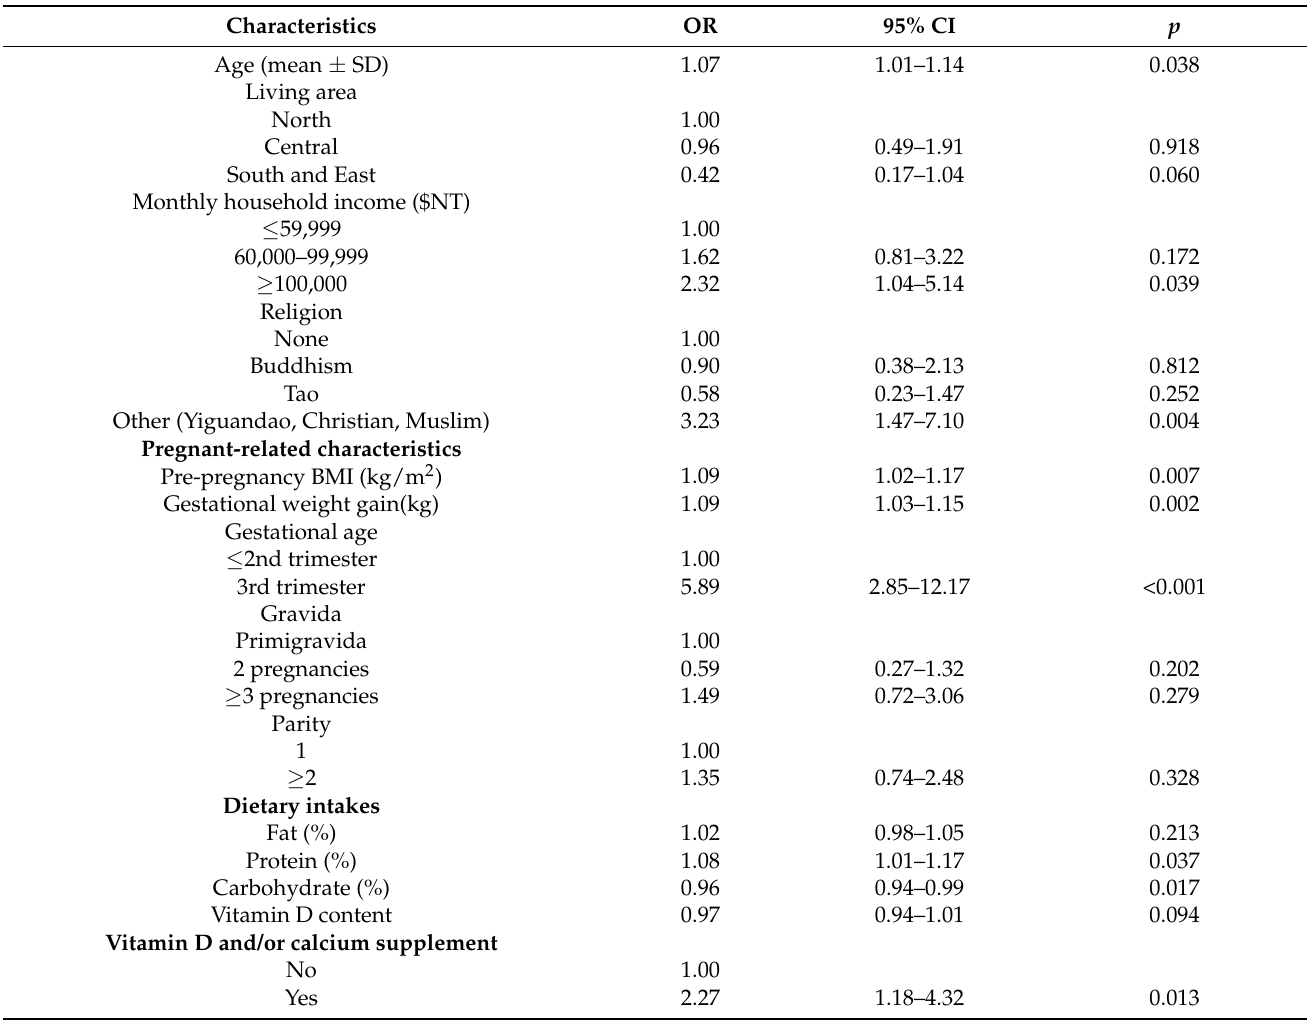
Table 2. Univariate logistic regression analysis to estimate odds ratio (and 95% CI) of having gestational diabetes mellitus according to characteristics of pregnant